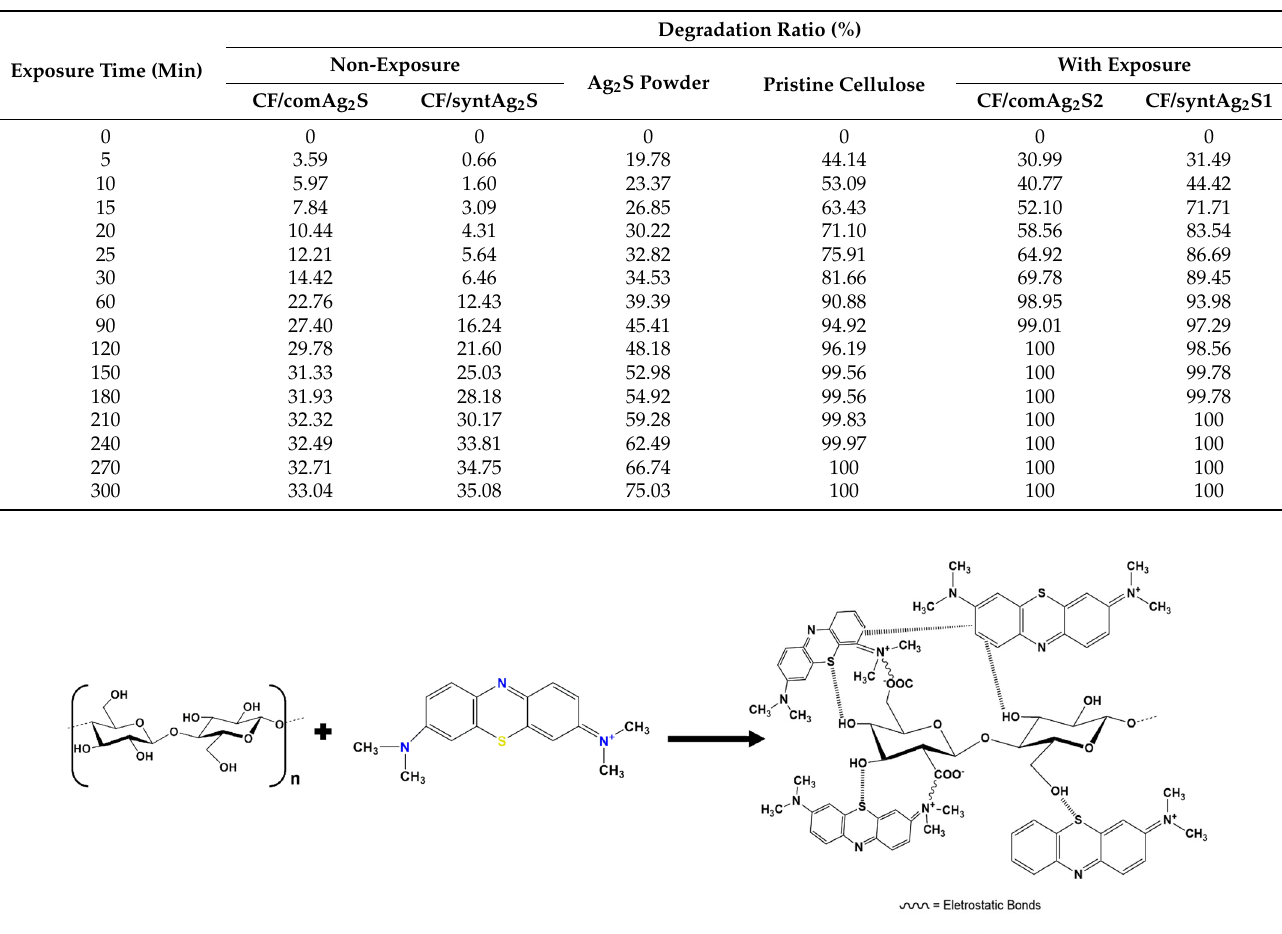
Table 5. Comparison of the photocatalytic efficiency of the prepared samples.